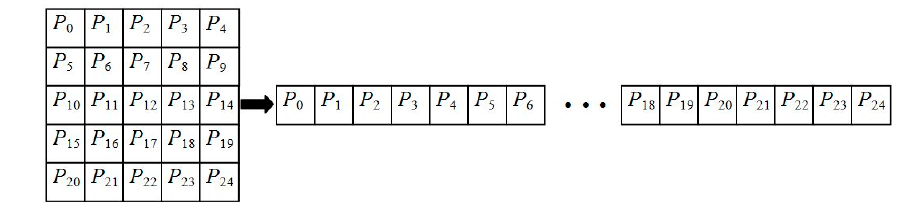
Figure 8. Row feature vector representation.